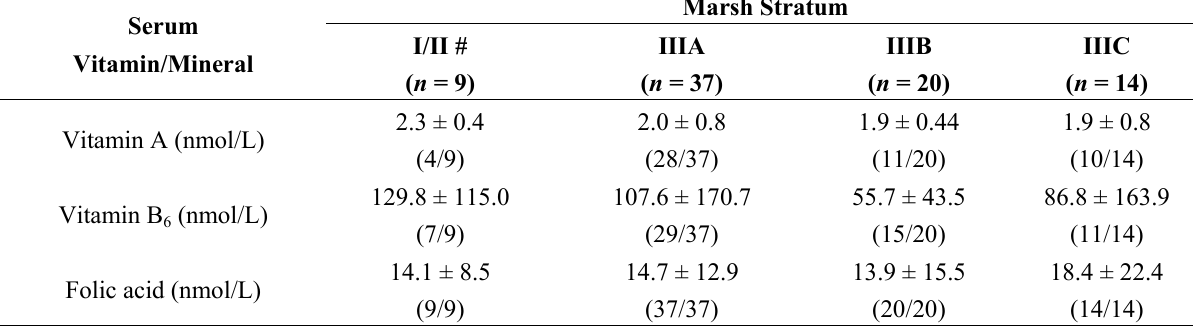
Table 4. Mean serum concentrations of vitamins and minerals (±SD) in untreated CD-patients by Marsh